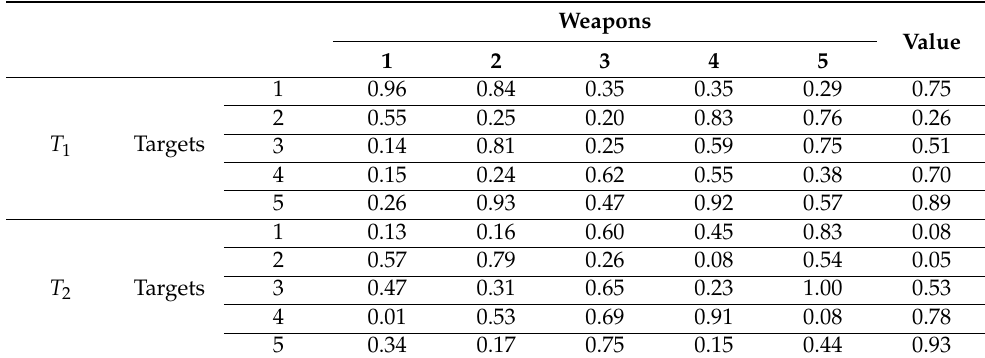
Table A1. Details of the destructive value of every target and the probability of kill for every weapon in the two component tasks of problem 1 in Table 2. Each task is a WTA problem.